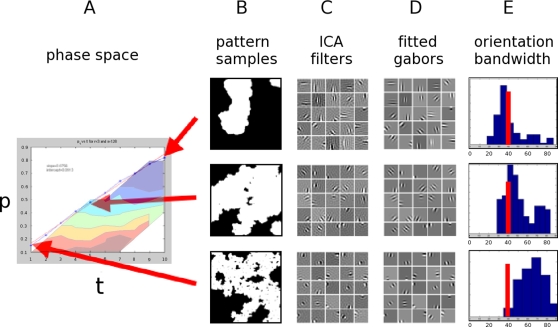
Summary of pattern sampling and analysis demonstrating relevant variation in derived gabor filters.(A) Phase plane with ‘r’ fixed at 3. The curved line in the plot indicates the phase transition boundary as detailed in the methods section. The transparent color contours below the phase transition line indicate the trend for the median orientation bandwidth in that area of the plane. (B) Sampled patterns from (p,r,t) space near the critical percolation threshold - (0.15,3,1), (0.48,3,5) and (0.83,3,10). (C) The 16×16 pixel derived ICA filters. (D) Seven parameter gabor fits of those filters. (E) Histograms of the gabor orientation bandwidths in blue compared to the physiological median in red.